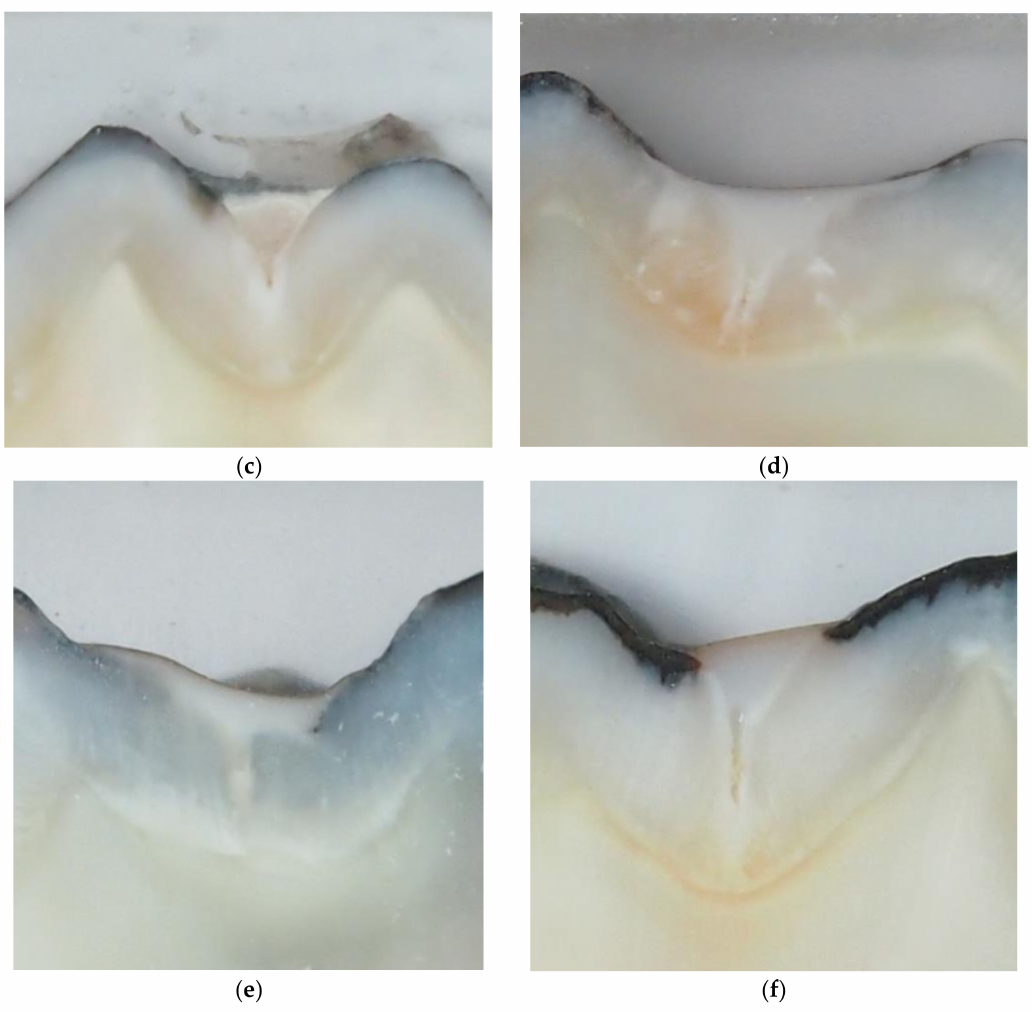
Figure 1. Score scheme of dye penetration at the material / tooth interface ( a ): 0-no evidence of dye penetration; 1-dye penetration of less than 1 / 3 from the margin of restoration; 2-dye penetration of more than 1 / 3 and less than 2 / 3 from the margin of restoration; 3-dye penetration of more than 2 / 3